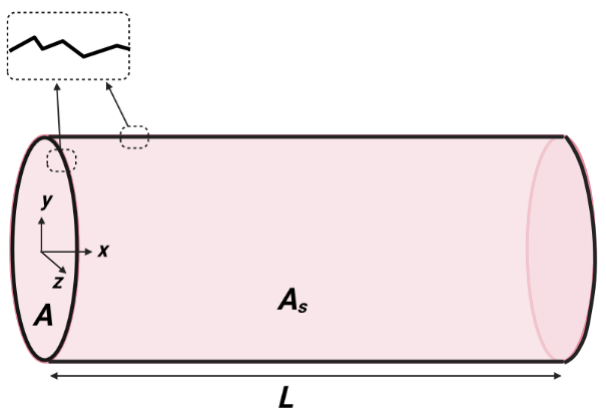
Figure 3. Schematic of a viscous fluid flow through a rough-walled